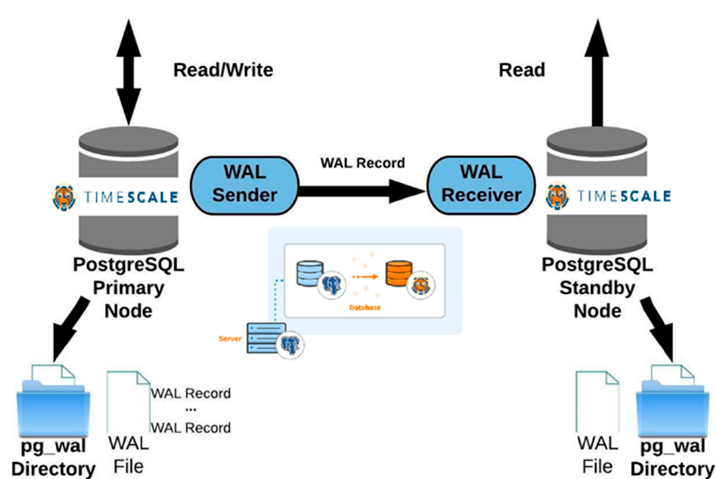
Figure 2. PostgreSQL and TimescaleDB—Streaming Replication.